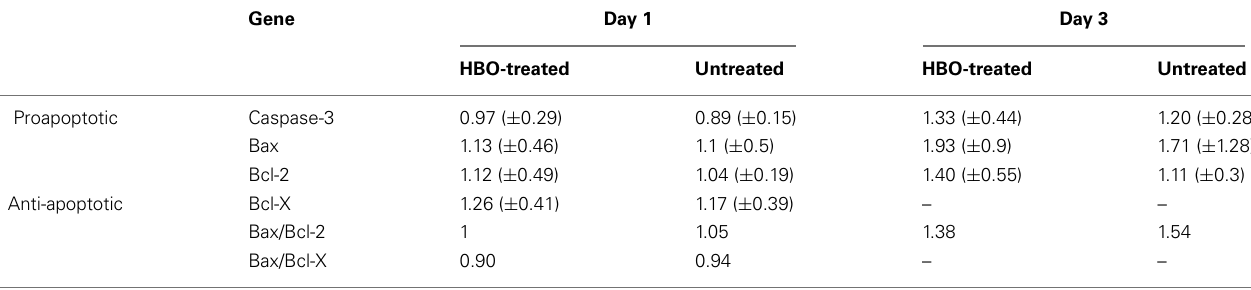
Table 3 | Expression of apoptosis-related genes following rAION induction at various time points, with and without HBO treatment.